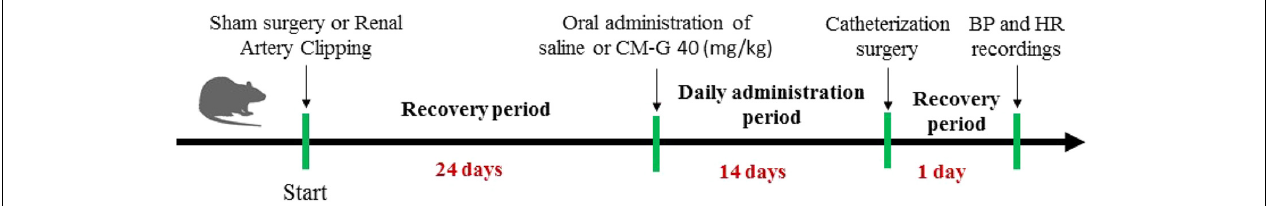
FIGURE 1 | Experimental design performed in the study.